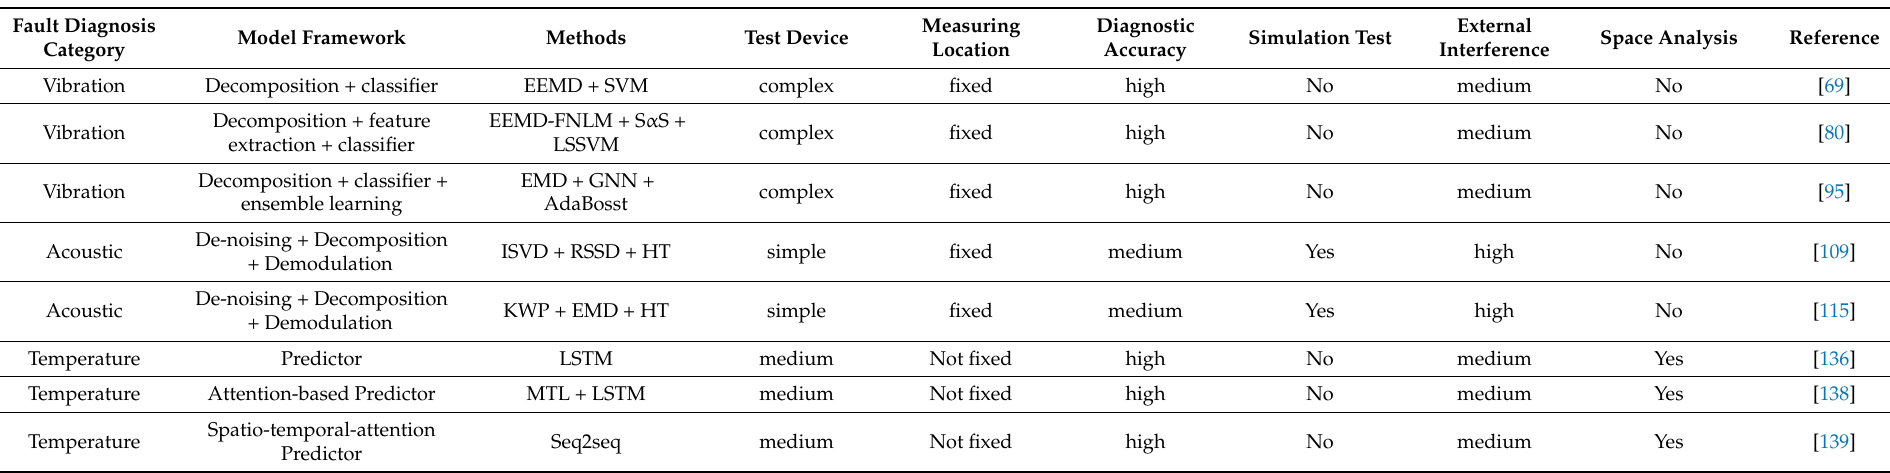
Table 5. Comparative performance of different fault diagnosis